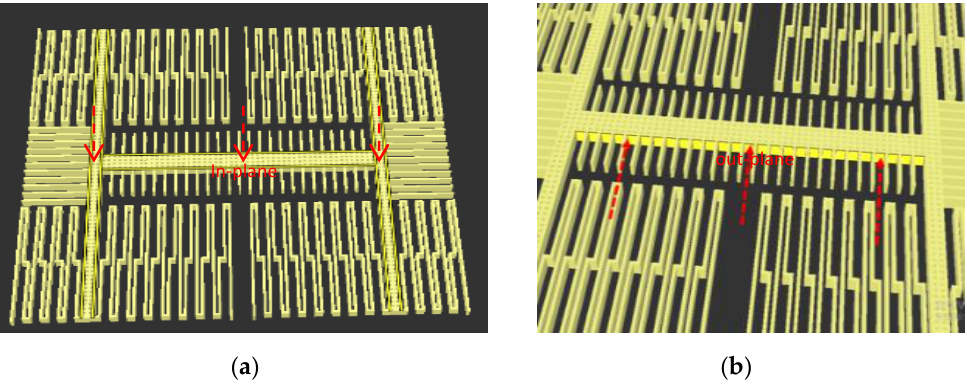
Figure 2. ( a ) Model of sensing x- and y-axis (in-plane) magnetic field; ( b ) model of sensing z-axis (out-plane) magnetic